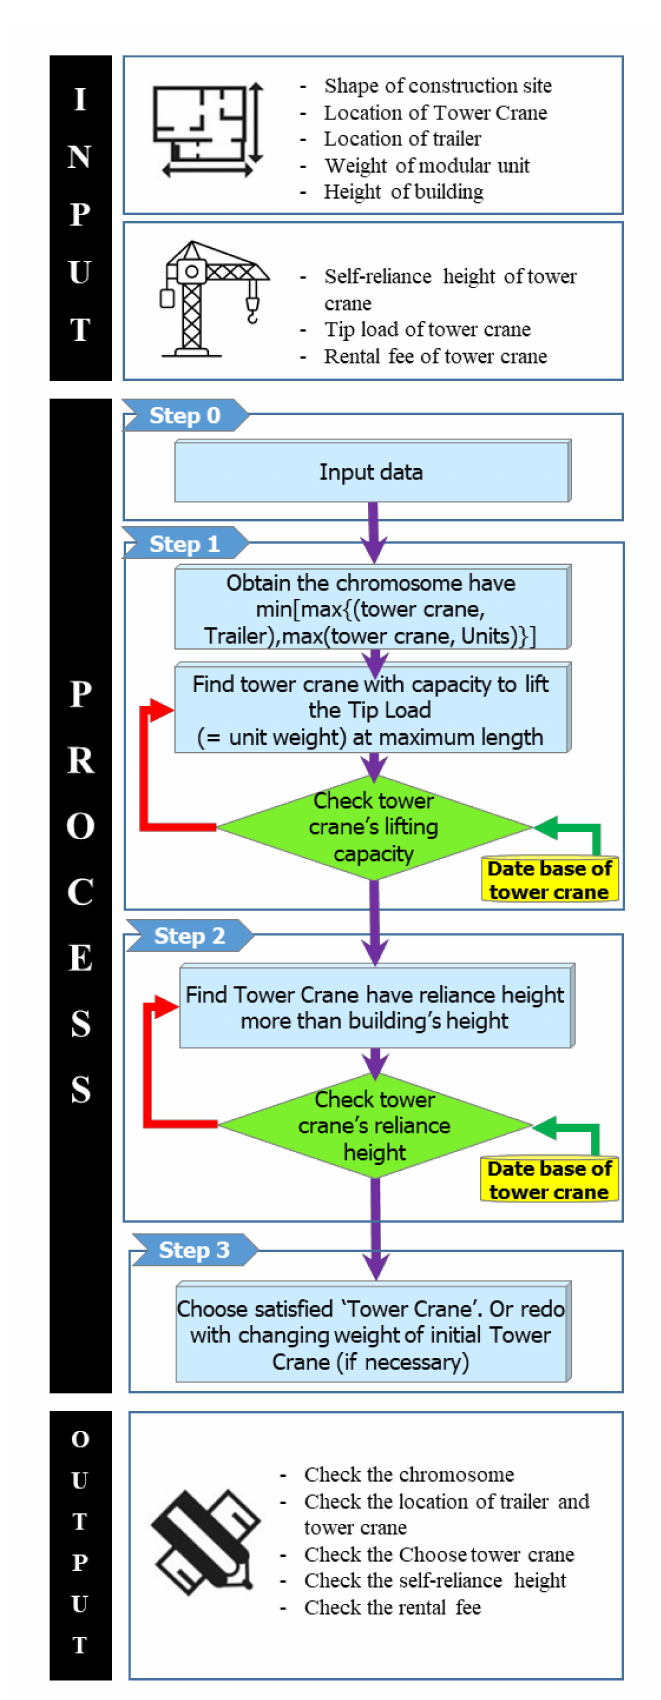
Figure 1. Tower crane selection model